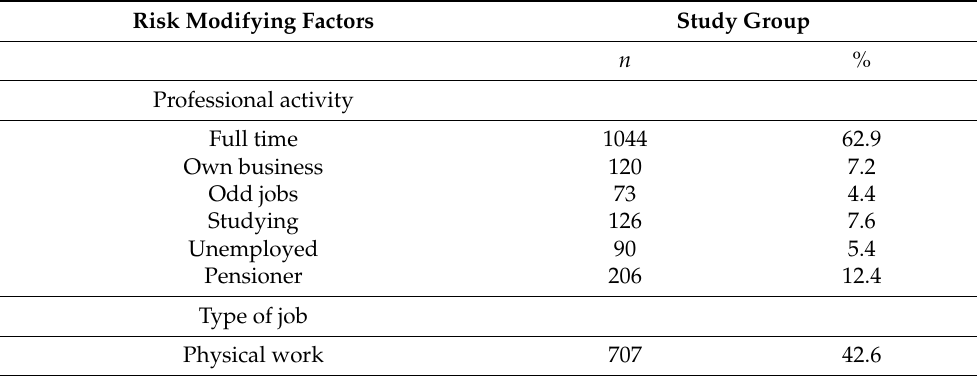
Table 1. Characteristics of the study group—selected risk modifying